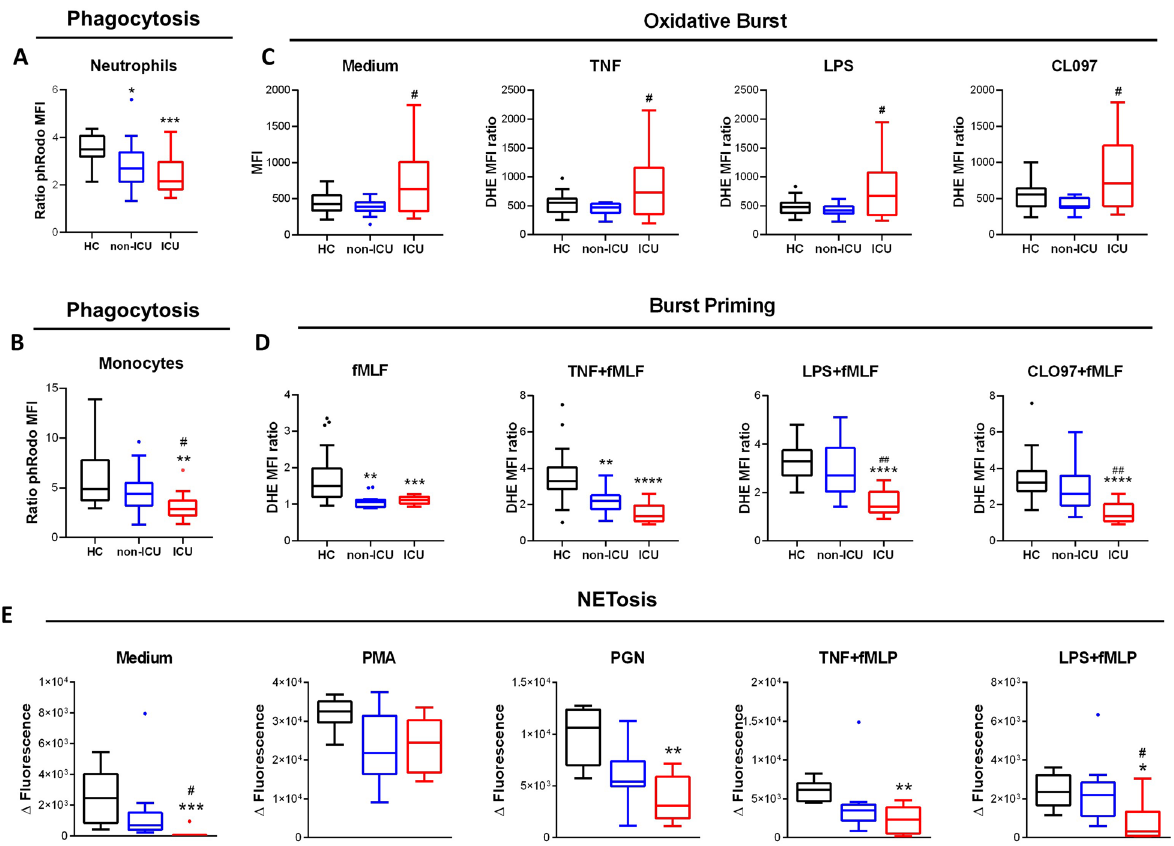
Figure 4. Anti-microbial functions of circulating phagocytes are impaired in severe COVID-19. ( A , B ) Measurement of phagocytosis capacity by phRodo-conjugated Zymosan particles uptake in ( A ) neutrophils and ( B ) monocytes. ( C , D ) Measurement of ( C ) oxidative burst in response to medium, Tumor Necrosis Factor alpha (TNF), lipopolysaccharide (LPS), TLR8 ligand CLO97, and ( D ) priming of formyl-methionine-leucine- phenylalanine (fMLF)-induced burst by TNF, LPS and CLO-97 in neutrophils. ( E ) Measurement of neutrophils NETosis capacity in response to medium, phorbol myristate acetate (PMA), peptidoglycan (PGN), TNF and fMLF, LPS and fMLF. Intergroup comparison by Mann–Whitney U test between healthy controls and ICU or non-ICU patients, ****P < 0.0001, ***P < 0.001, **P < 0.01, *P < 0.05., between non-ICU and ICU patients, ## P < 0.01, # P < .05. All boxplots whiskers represent 10th and 90th